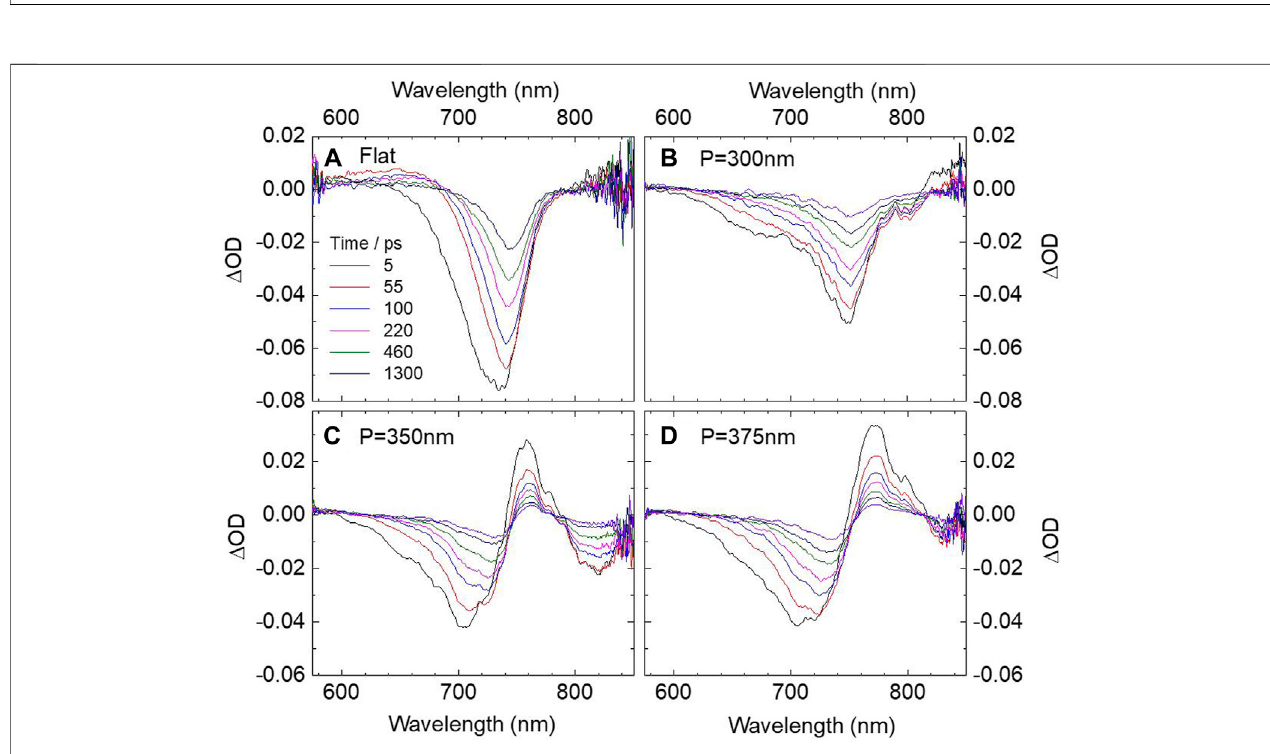
FIGURE 4 | Transient absorption spectra of CH 3 NH 3 PbCl x I 3-x perovskite fi lm on fl at (A) Al fi lm and (B – D) different Al nanopit arrays with periods of 300, 350, and 375 nm under 560 nm excitation. The spectra are recorded at 5, 55, 100, 220, 460, and 1300 ps.